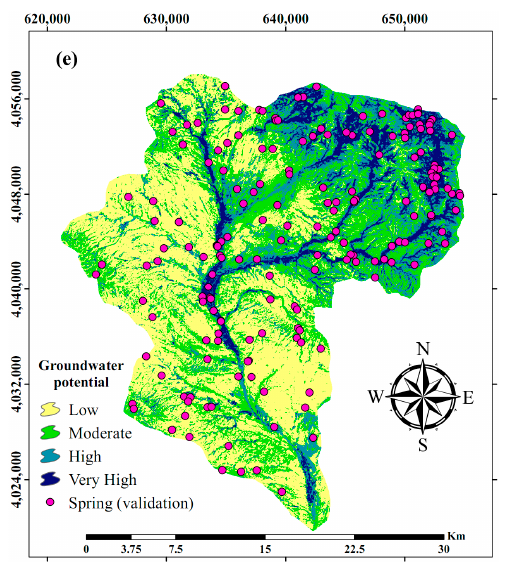
Figure 9. Distribution of groundwater (GW) potential in the study area based on: ( a ) logistic model tree, ( b ) deep boosting, ( c ) boosted regression trees, ( d ) k-nearest neighbors, and ( e ) random forest MLAs. Table 5. Range and area of each class of the GW potential maps constructed by the logistic model tree, deep boosting, boosted regression trees, and k-nearest neighbors.